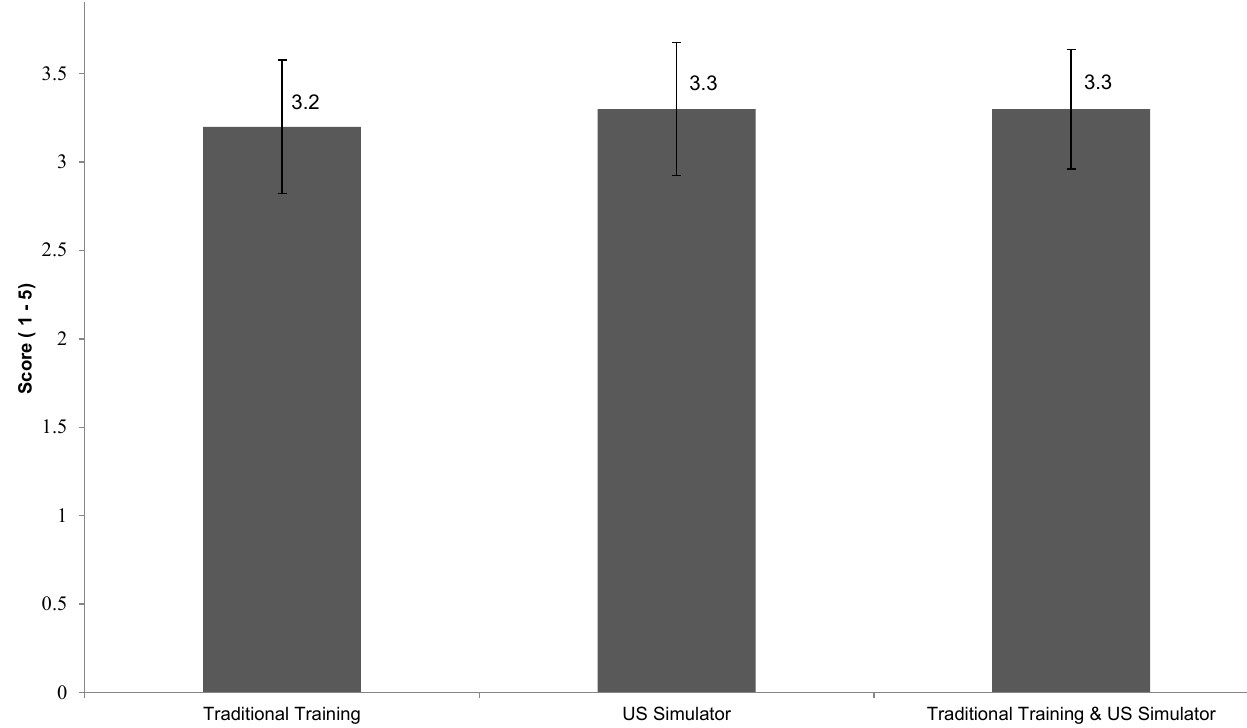
Figure 2. SDOT image acquisition scores across groups. SDOT , standardized direct observation tool; US , ultrasound Data are reported as mean with 95% CI. Images were rated by the evaluator on a 1-5 scale (1 – No information provided by the image, 3 – Adequate image to make a clinical decision, 5 – Textbook quality